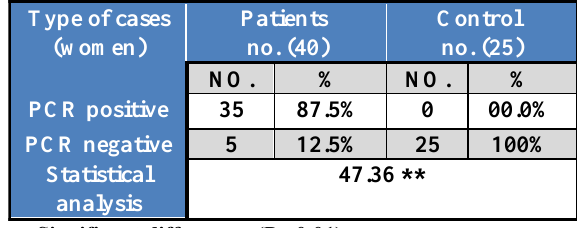
Tabel, 3: Nested PCR result for human blood sample